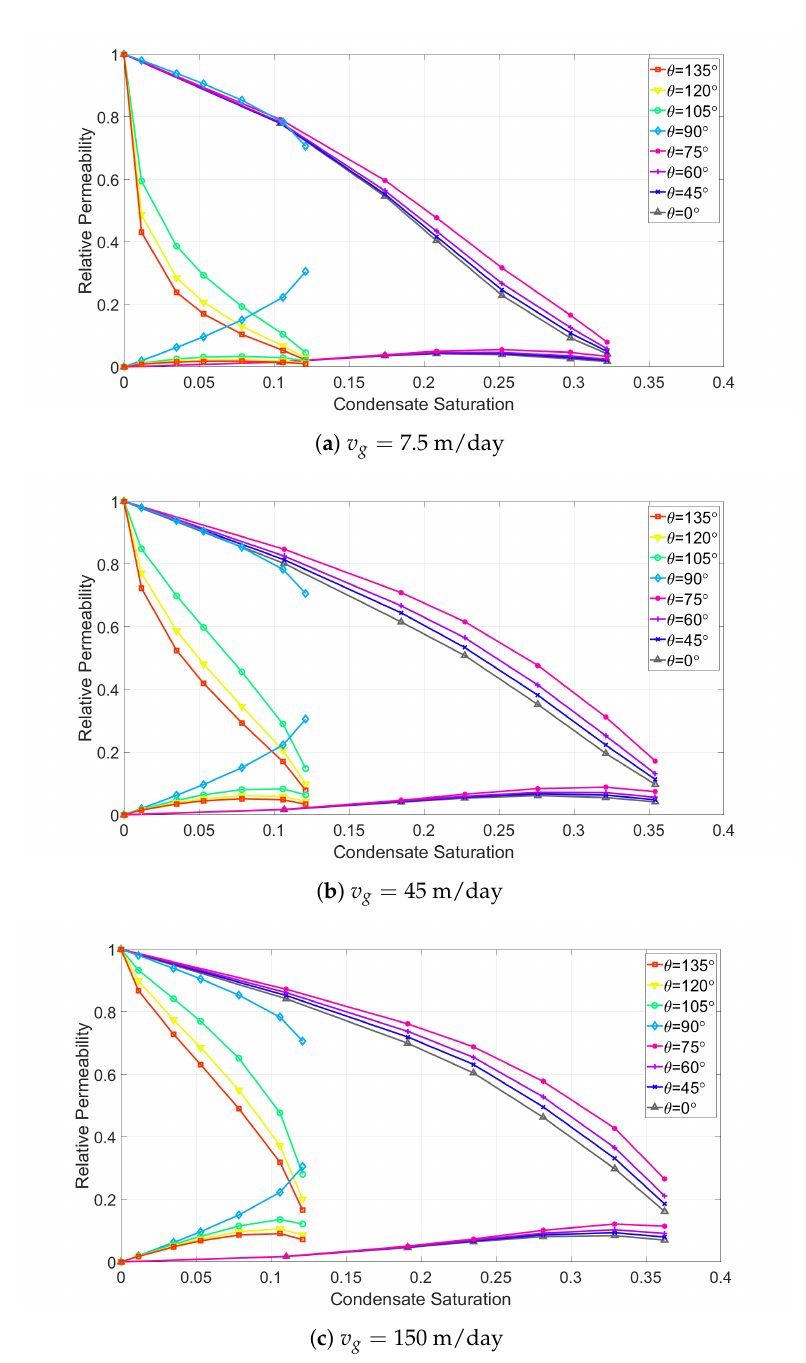
Figure 9. Relative permeability curves at different gas flow